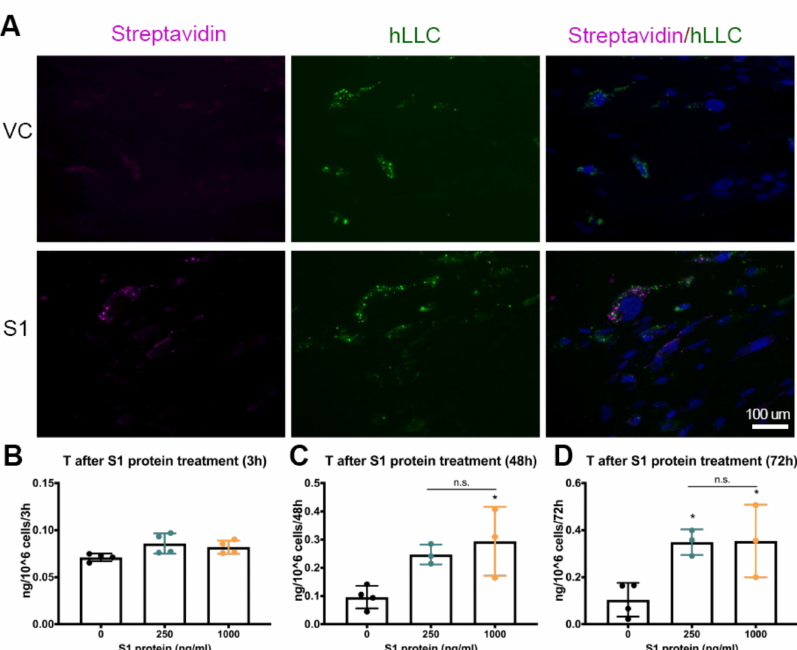
Figure 3. SARS-CoV-2 spike protein subunit 1 (S1) can interfere with T production by hLLCs. ( A ). After fixation, hLLCs were incubated with biotin-labeled SARS-CoV-2 S1 protein (S1 group, 10 µ g/mL) or without S1 protein (VC group) for 18 h. Both S1 and VC groups were further incubated with fluorescent-conjugated streptavidin for 90 min. Streptavidin binding to hLLCs is indicated by purple fluorescence. The hLLCs are indicated by green fluorescence inserted during induction. The overlap of purple and green signals suggests that streptavidin can only bind to hLLCs in the presence of S1 protein. (Scale bar: 100 µ m) ( B – D ) Similar to the experimental conditions in ( A ), hLLCs were treated with 250 or 1000 ng/mL of S1 protein for 3, 48, or 72 h. S1 protein significantly stimulated T production at either 250 or 1000 ng/mL at both 48 h and 72 h. Data are presented as means ± SDs, n ≥ 3. Not significant = n.s. at p > 0.05; * p <